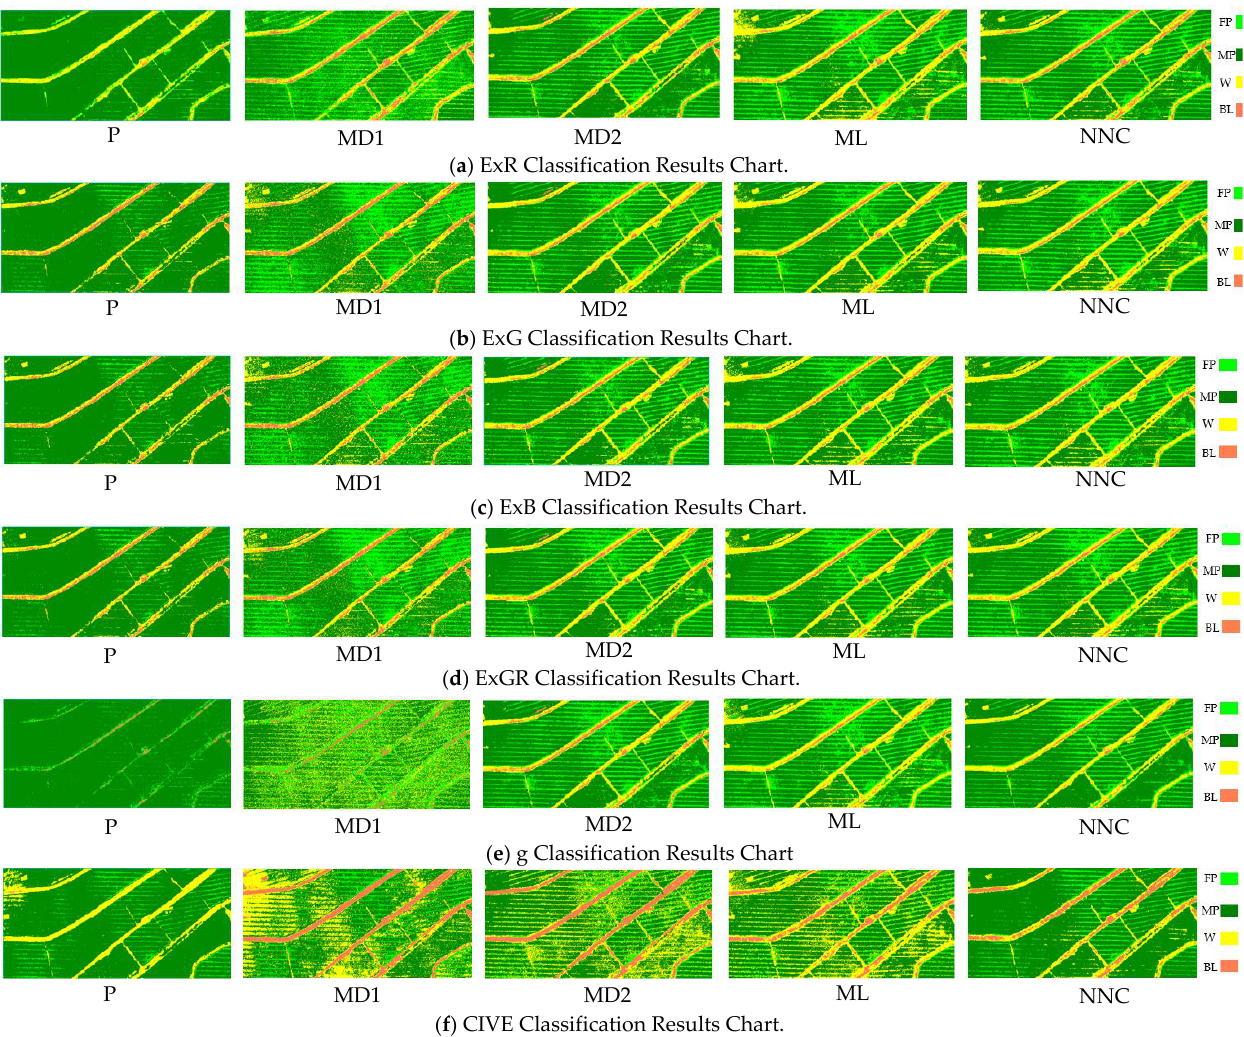
Figure 5. Results of visible light vegetation indices. FP: Female parent; MP: Male parent; W: Weed; BL: Bare land; P: Parallelepiped; MD1: Minimum Distance; MD2: Mahalanobis Distance; ML: Maximum Likelihood; NNC: Neural Network Classification.